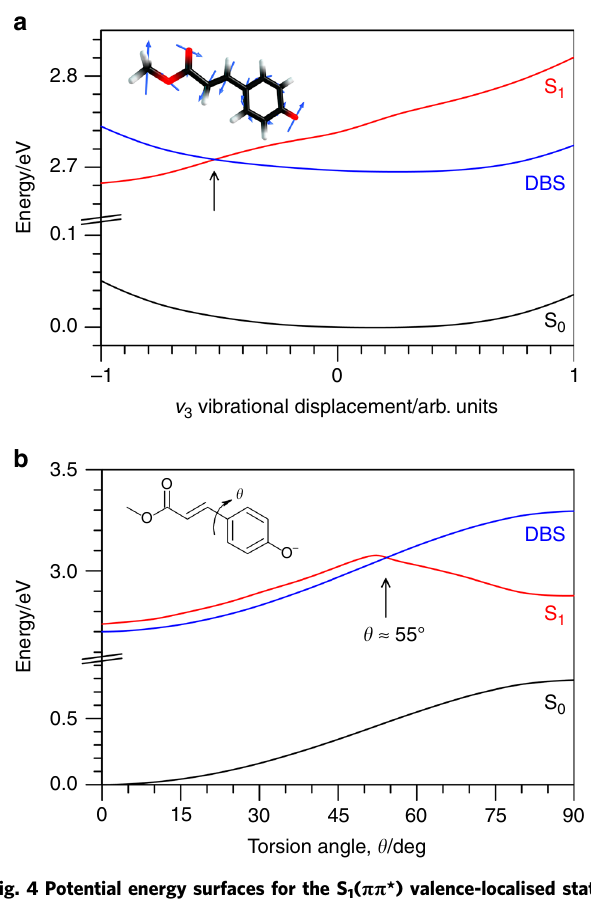
Fig. 4 Potential energy surfaces for the S 1 ( ππ *) valence-localised state and the dipole-bound state. The potential energy surfaces are represented by a black line for the ground state, a red line for the S 1 ( ππ *) valence- localised state, and a blue line for the dipole-bound state (DBS), respectively. a Potential energy surface calculation for motion along the principal Franck-Condon active vibration, ν 3 , with displacement vectors shown on the molecular structure in the inset. 0 corresponds to the initial anion geometry, − 1 and 1 correspond to turning points for the ground vibrational level. b Potential energy surface calculation for rigid torsion scan about the single-bond connecting the phenyl and alkene tail by angle θ , as shown inset, with 0° corresponding to the initial anion geometry and 55° to a crossing of valence and non-valence surfaces. Note, the calculated S 1 ( ππ *) vertical excitation energy and VDE (not shown) at the anion equilibrium geometry are both ≈ 0.1 eV lower than